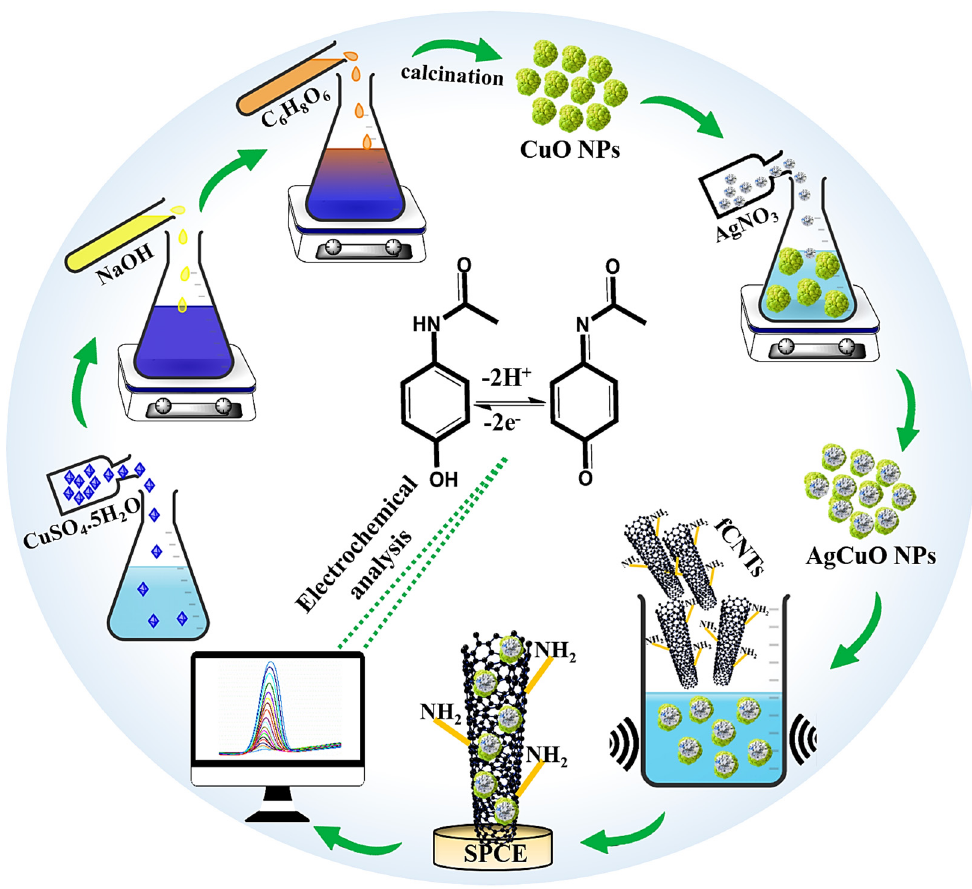
Scheme 1. Illustration of AgCuO NPs/fCNTs preparation for APAP